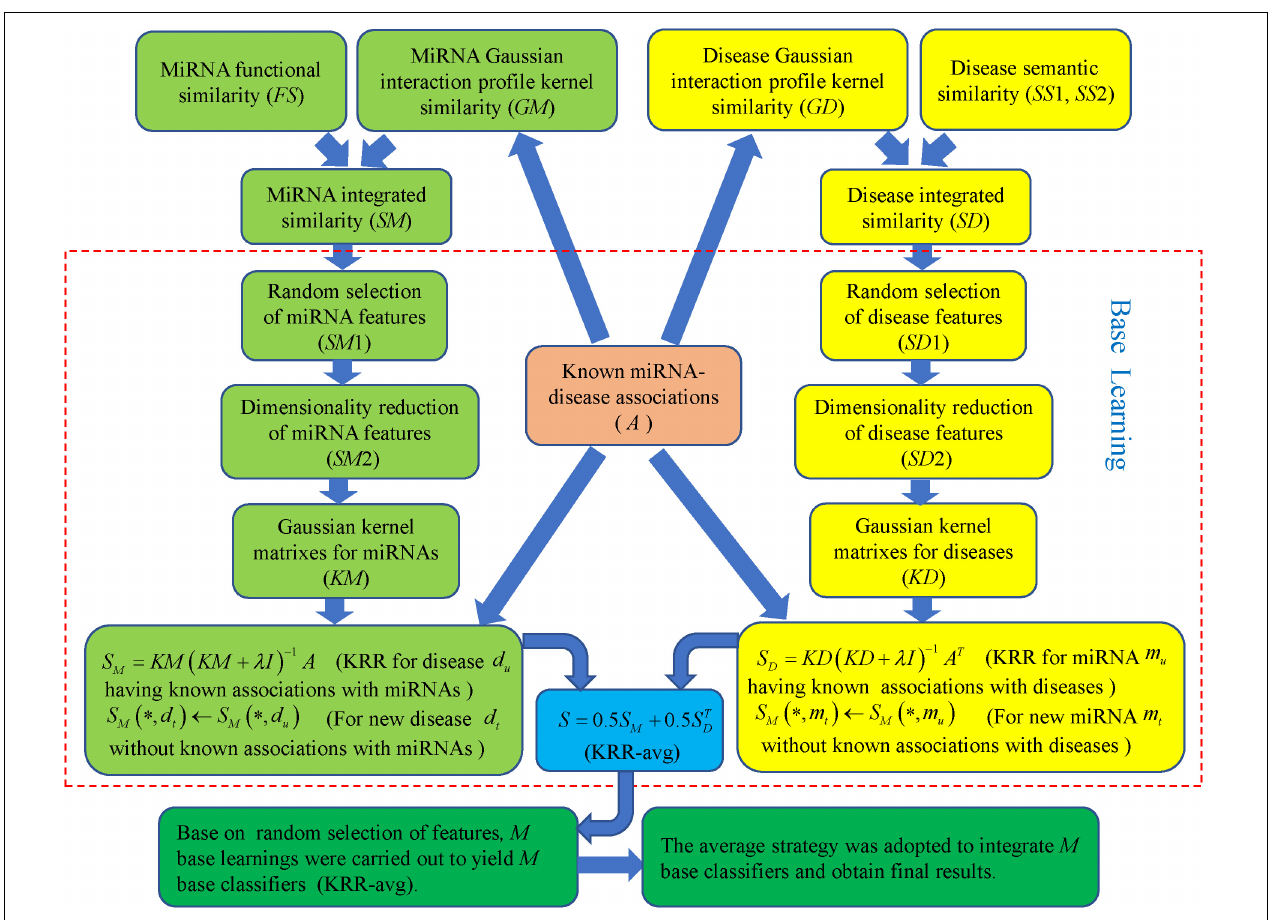
FIGURE 1 | Flowchart of EKRRMDA to predict the potential miRNA-disease associations based on the known associations in HMDD V2.0 database.